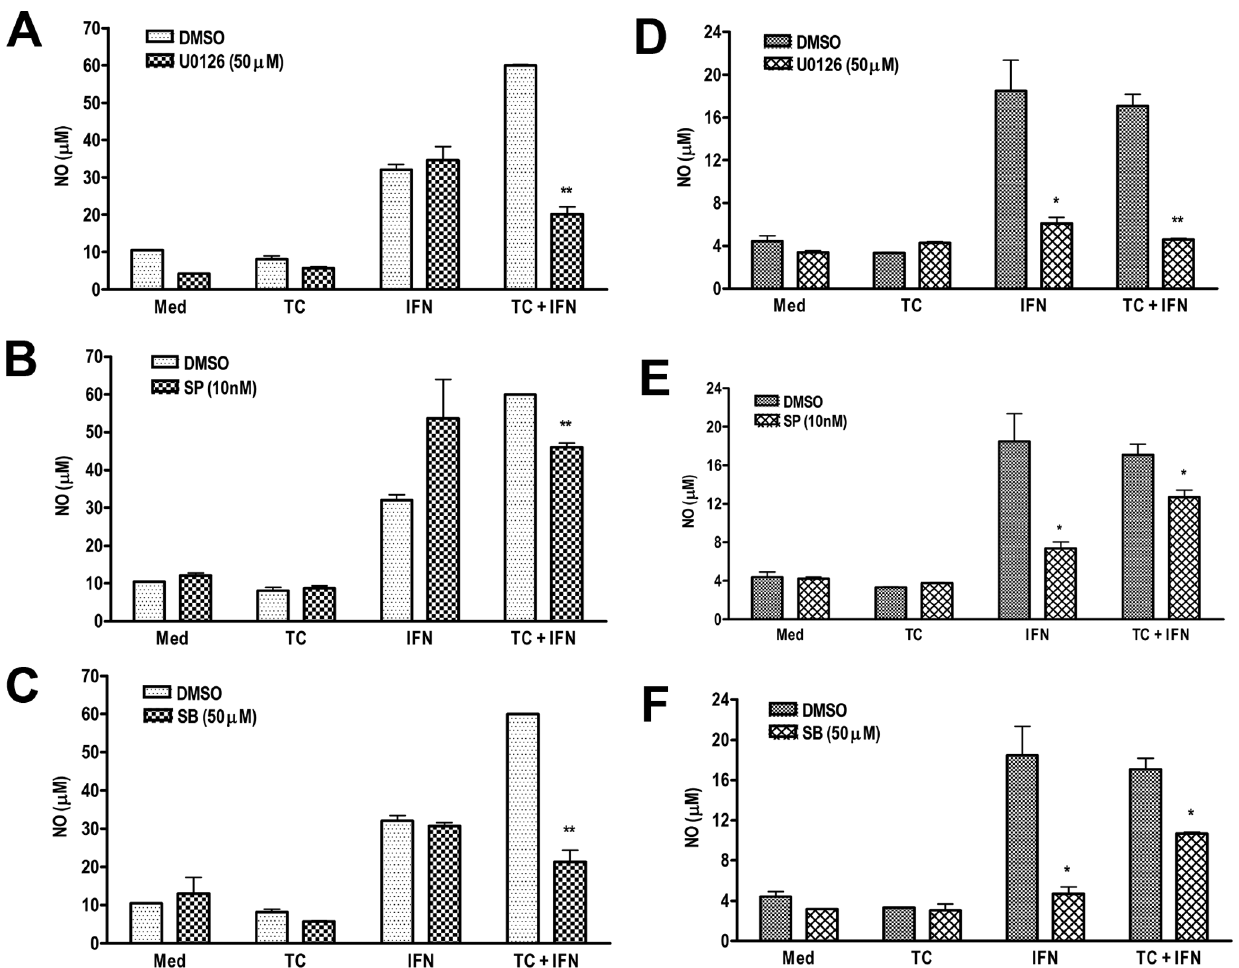
Figure 4. MAPK (Erk K , JNK, and p38) inhibitors abrogate the TC and IFN- c -induced NO release in macrophage cell lines. Serum- deprived ANA-1 (A, B, C) and BALB.BM (D, E, F) were incubated with MAPK inhibitors (U0126 for Erk1/2, A and D; SP600125 for JNK, B and E; and SB203580 for p38, C and F) for 1 h prior to stimulation with IFN- c and TC in combination or alone, and nitric oxide (NO) release was measured in supernatants by Greiss’ Reaction. Data presented are representative of 3 different experiments with similar findings. *, p , 0.05; **, p , 0.0 1 compared to respective stimulated cells treated with DMSO (vehicle).